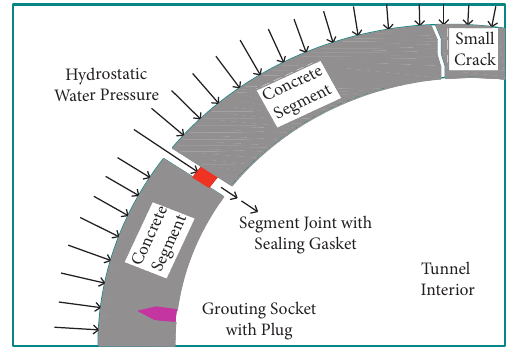
Figure 5: Illustration of leakage point (reannotated based on references [84,